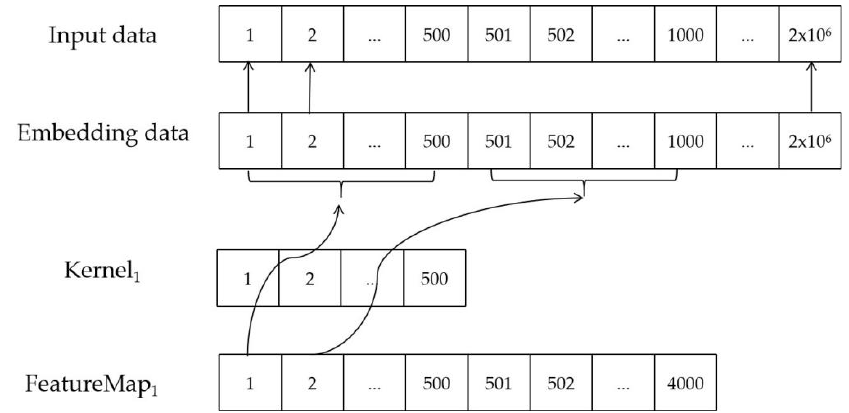
Figure 3. Mapping feature map back to raw data.